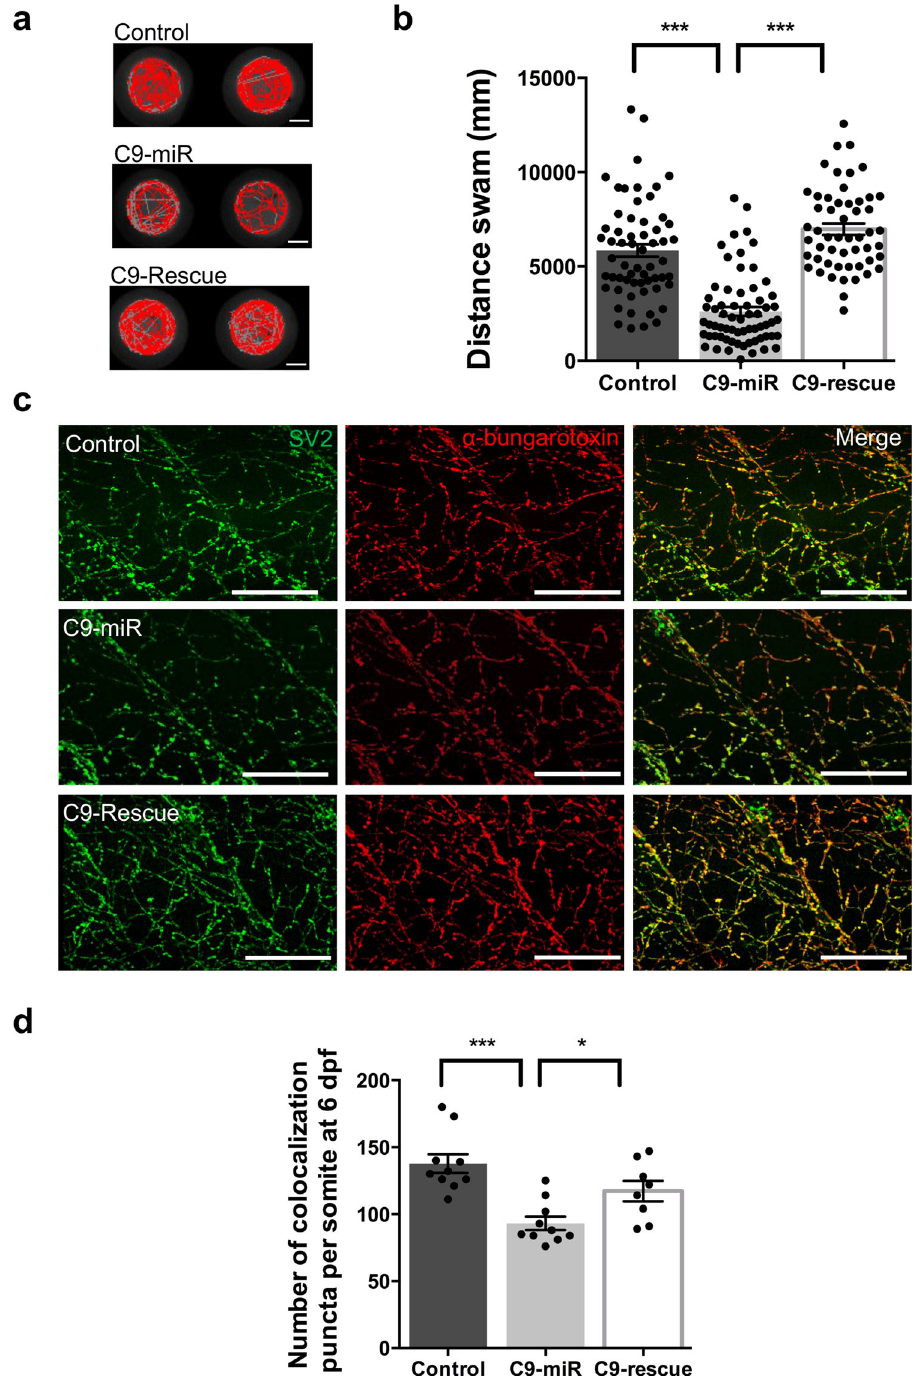
Fig. 2 Motor behavioural de fi cits and reduced acetylcholine receptor clusters at neuromuscular junctions (NMJs) in C9-miR fi sh. a Representative swimming tracks of control, C9-miR and C9-rescue fi sh at 6 dpf. Scale bar = 0.2 cm. b C9-miR larvae ( N = 3, n = 65) displayed impaired swimming compared to controls ( N = 3, n = 60; *** p < 0.0001; one-way ANOVA). Expression of the human C9orf72 long transcript in C9-miR fi sh (C9-rescue; N = 3, n = 53) signi fi cantly rescued the motor behavioural defects (*** p < 0.0001; one-way ANOVA). c Representative images of co-immunostaining of zebra fi sh neuromuscular junctions with presynaptic (SV2; green) and postsynaptic ( α -bungarotoxin; red) markers in 6 dpf zebra fi sh. Scale bar = 100 μ m. d Quanti fi cation of the colocalizing presynaptic and postsynaptic markers per somite showed a signi fi cant reduction in the number of puncta in C9-miR fi sh at 6 dpf that can be rescued with the expression of human C9orf72 mRNA (C9-rescue) ( n = 8 – 10; *** p < 0.0001; one-way ANOVA). Data are presented as mean ± SEM. n represents the number of fi sh, N represents the number of experimental